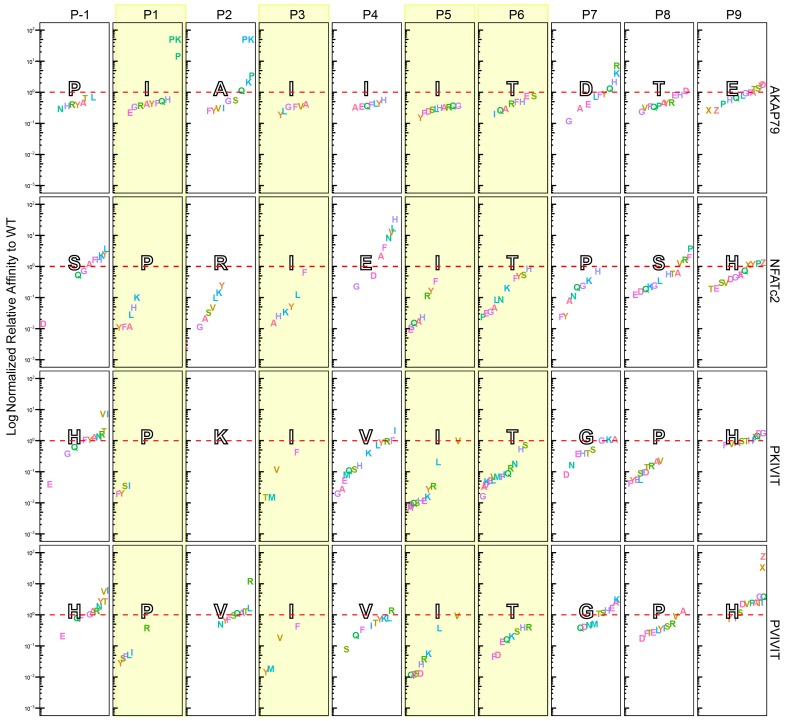
Visualization of Log Ka normalized to corresponding WT sequences.Amino acid substitutions (single letter code) for all four scaffolds: PVIVIT, PKIVIT, NFATc2, and AKAP79. Positions P-1 to P9 are separated by columns and columns highlighted in yellow represents conserved positions from PxIxIT binding motif. Letters in large black-outlined text corresponds to the WT sequence for that scaffold. Red dotted line is relative affinity = 1. Phosphoserine and phosphothreonine are represented by 'X' and 'Z', respectively.